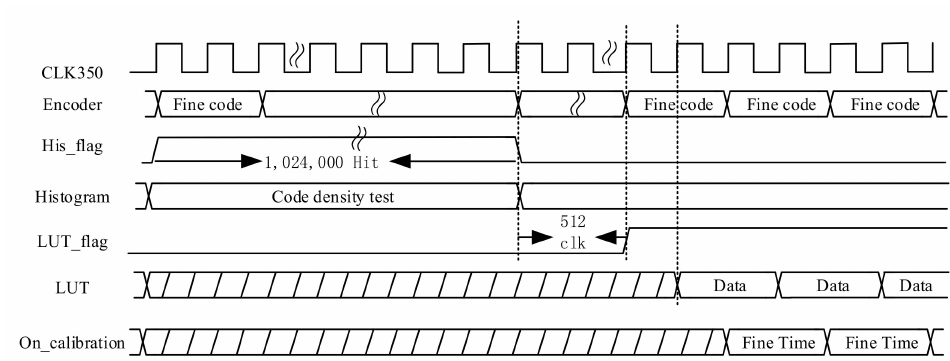
Figure 5. A timing diagram of the online calibration.